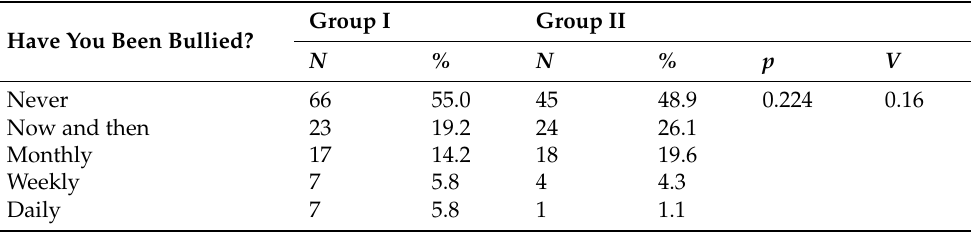
Table 4. Comparison of bullying prevalence based on the self-labelled subjective feeling of being bullied between two investigated groups.